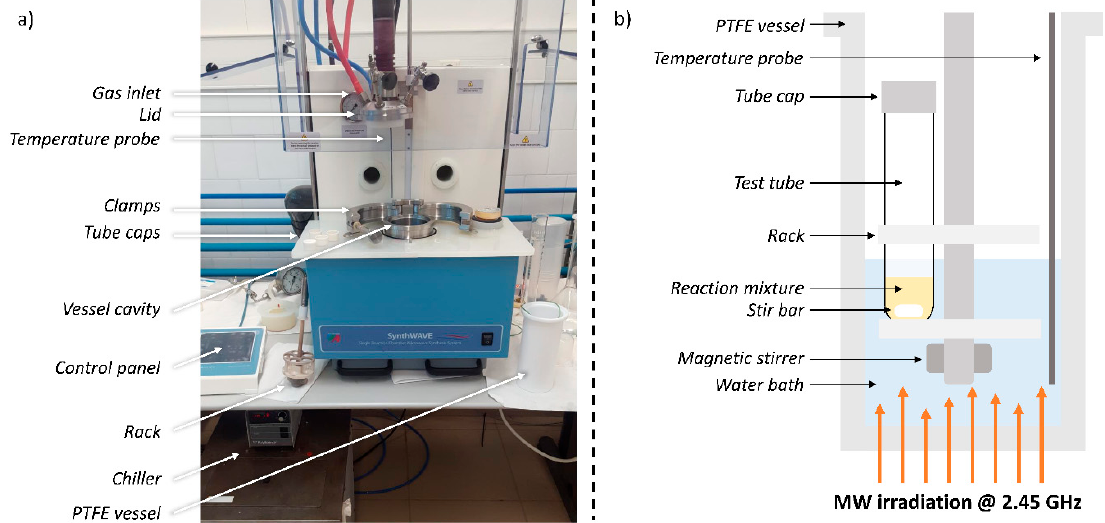
Figure 1. ( a ) Photograph of the microwave (MW) reactor, and ( b ) scheme of the reaction vessel during